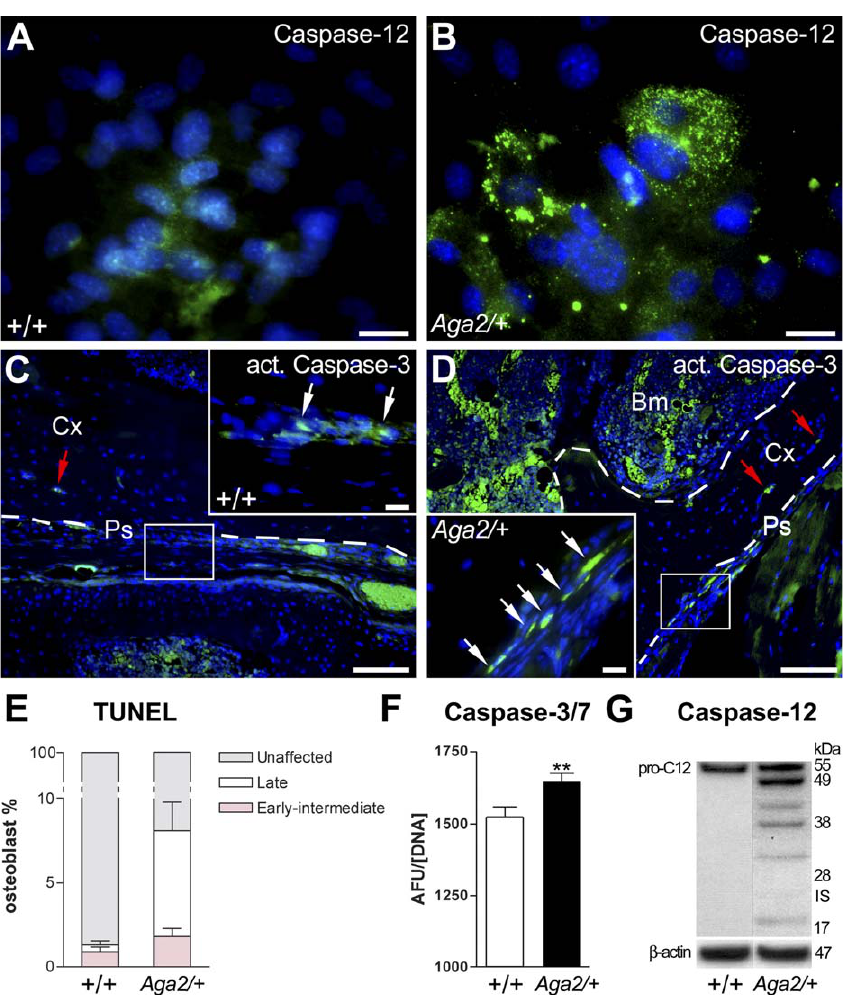
Figure 6. Initiation of Apoptosis in Aga2 / þ (A,B) Caspase-12 immunofluorescence of 16-d-old stimulated OBs. (C,D) Activated caspase-3 labeling of 12-wk-old distal femur depicting dying cells within the periosteum (white arrows) and cortical bone (red arrows). Nuclei were stained with DAPI. (E) Quantification of TUNEL stained 16-d-old stimulated calvarial OBs. (F) Caspase-3/7 OB activity was measured via a fluorometric substrate assay. (G) Western analysis of procaspase-12 using primary OBs. Results are presented as mean 6 SEM (* p ¼ 0.0002 ANOVA, and ** p ¼ 0.04 Student t -test), where n ¼ 4 independent experiments. Bars, 50 l m in (A) and (B), 100 l m in (C) and (D) main panels, 20 l m in (C) and (D) insets. Arbitrary fluorescent unit (AFU), bone marrow (Bm), cortical bone (Cx), low-present isoform (IS), periosteum